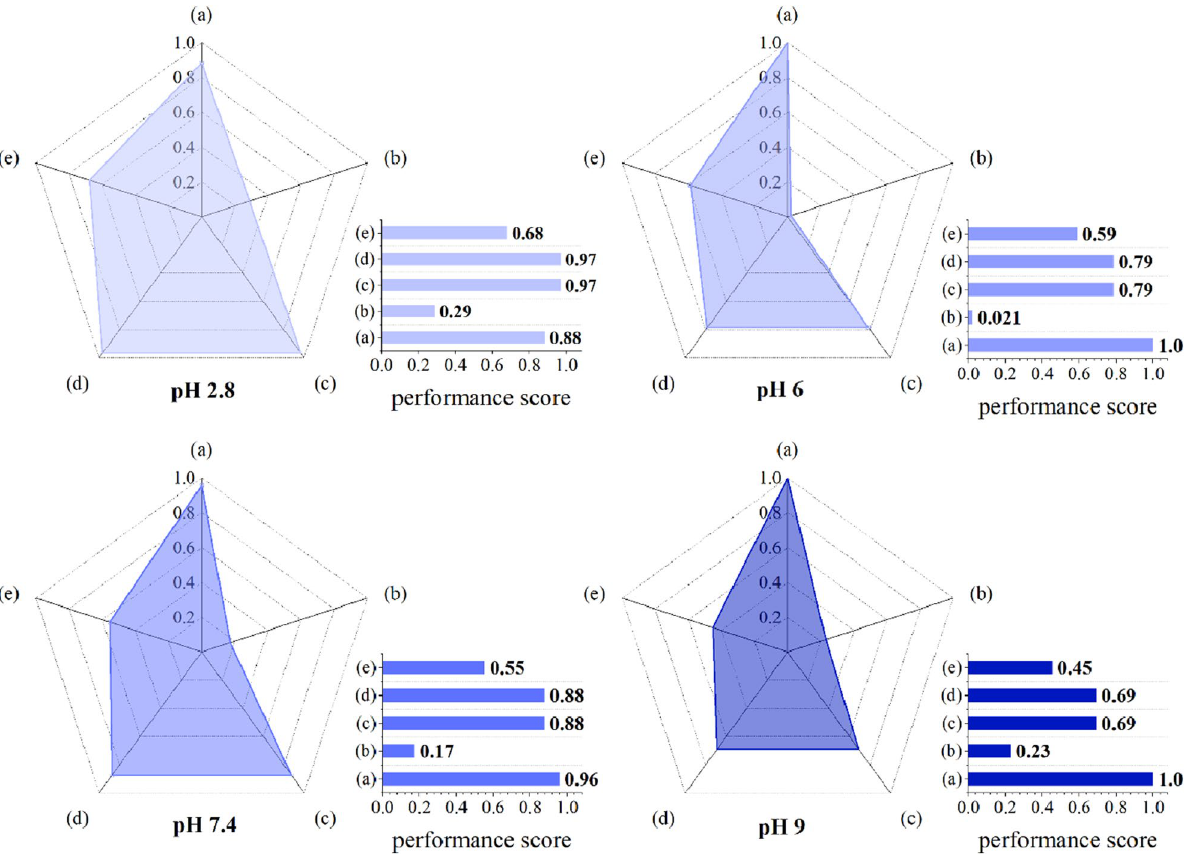
Figure 10. Plots of performance scores ( p i ) which were calculated based on the TOPSIS algorithm used for release kinetic model assessment at different pHs: ( a ) Korsmeyer–Peppas, ( b ) Higuchi, ( c ) Hopfenberg, ( d ) zero- order equation, and ( e ) first-order